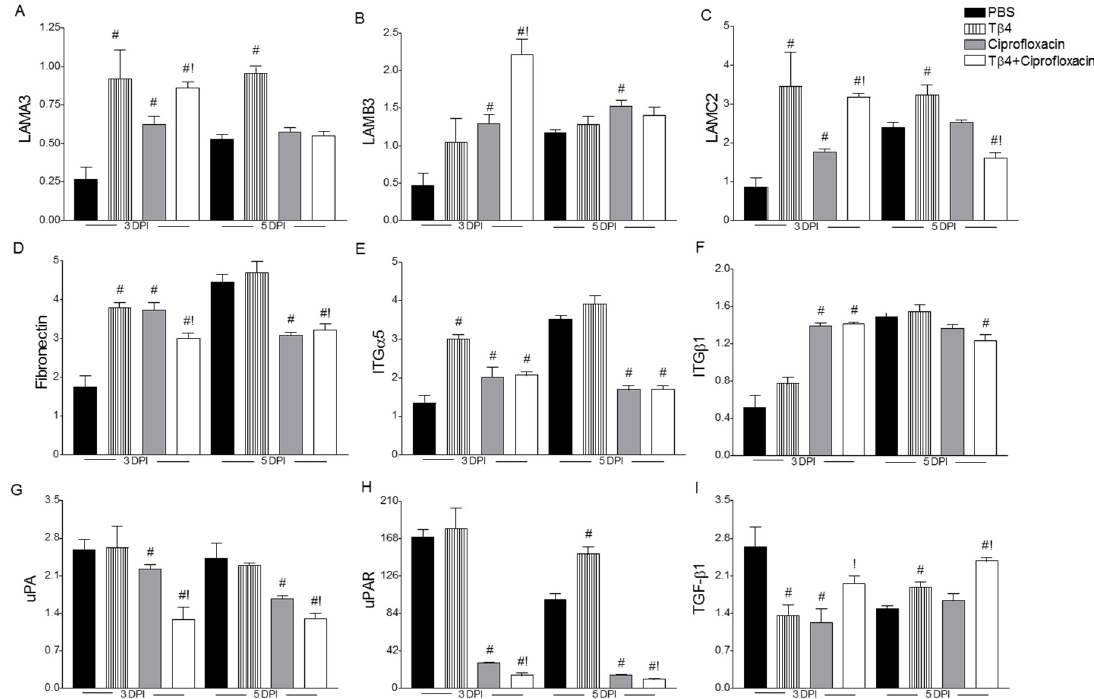
Figure 6. Transcript levels of select wound healing genes in corneas of PBS-, T β 4-, ciprofloxacin-, and T β 4 + ciprofloxacin-treated B6 mice at 3 and 5 days p.i. mRNA expression levels for LAMA3 ( A ), LAMB3 ( B ), LAMC2 ( C ), fibronectin ( D ), ITG α 5 ( E ), ITG β 1 ( F ), uPA ( G ), uPAR ( H ), and TGF- β 1 ( I ) are normalized to β -actin and represented as relative fold change for the gene of interest compared to normal (uninfected) controls ± SEM. N = 8 corneas/group/time point. # P < 0.05 versus PBS; ! P < 0.05 versus